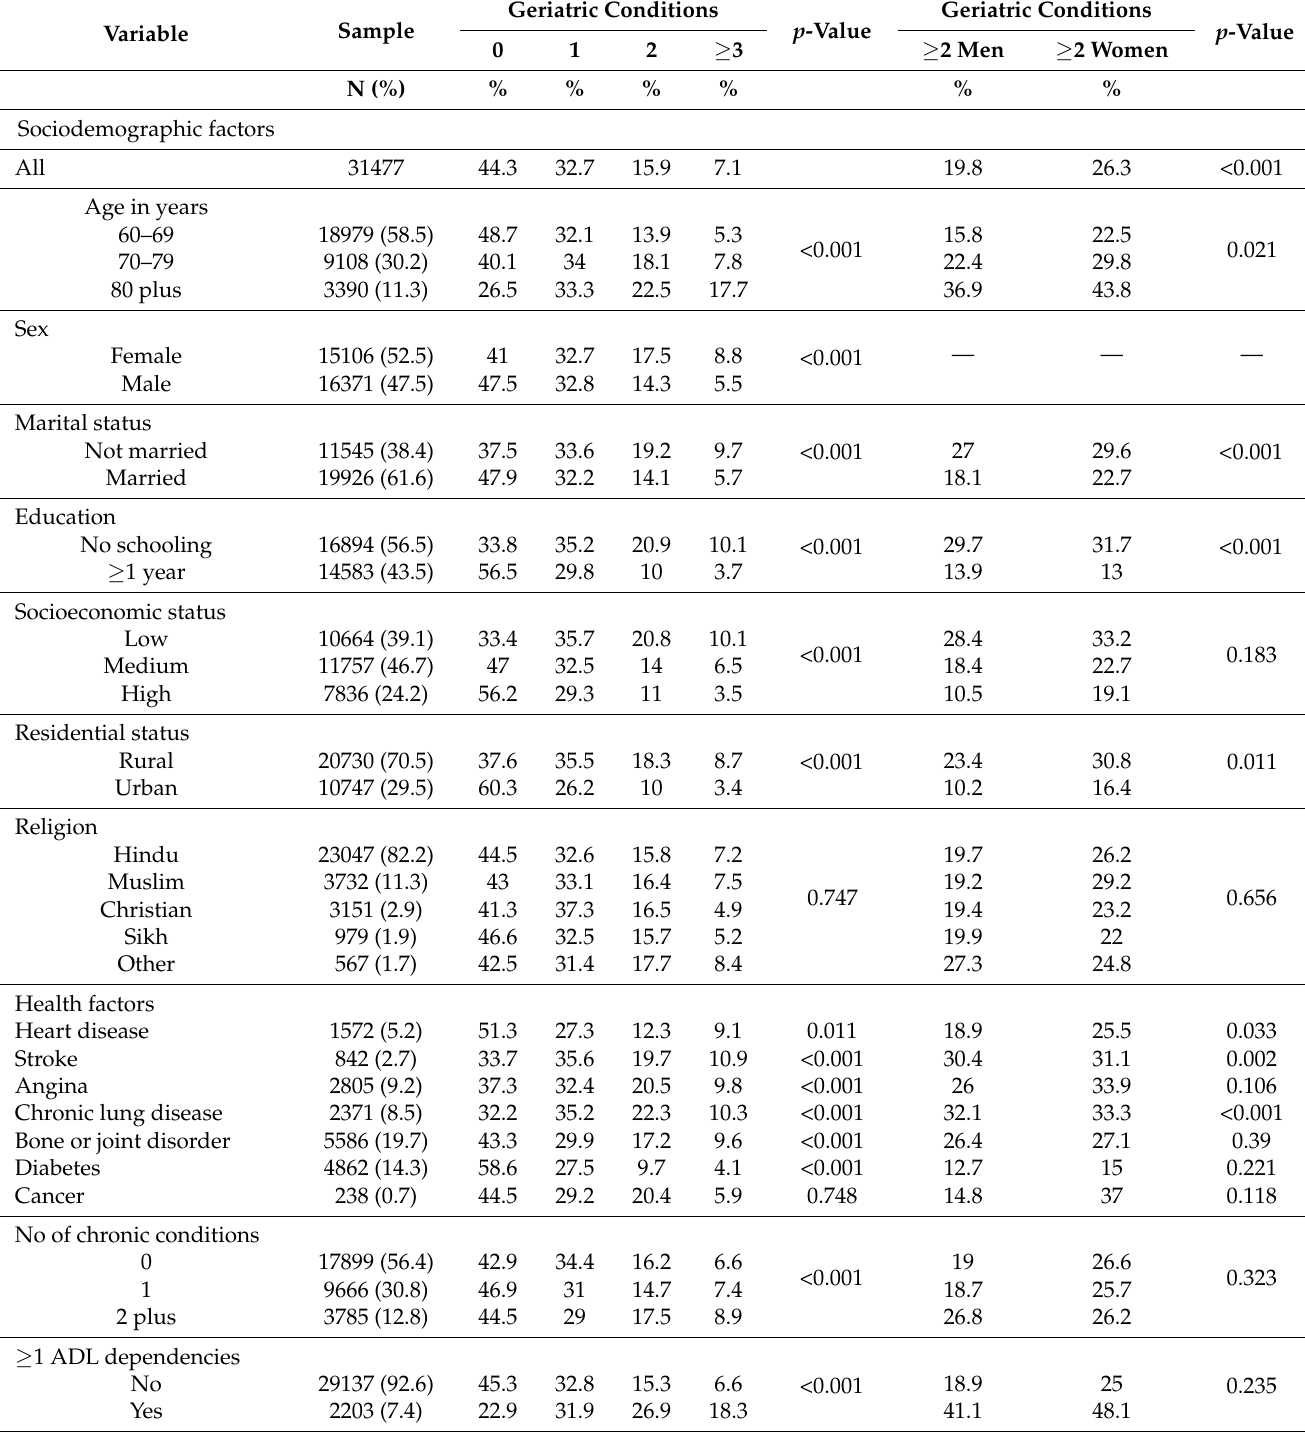
Table 1. Sample and geriatric condition characteristics among older adults ( ≥ 60 years) in India, 2017–2018.